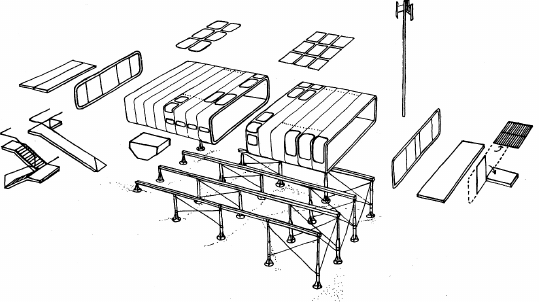
Figure 12. Autonomous House 1978 [47]. Photo: courtesy Richard Rogers +